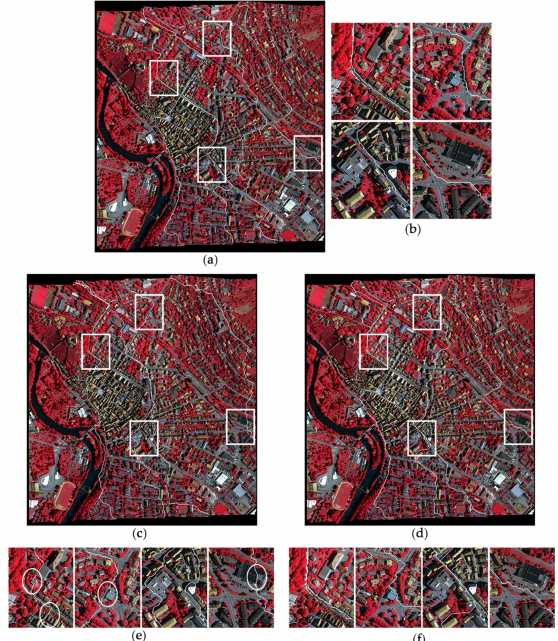
Figure 12. Results of seamline extraction and image mosaicking. ( a ) Seamline (white lines) extracted by the proposed algorithm; ( c ) seamline extracted by the Dijkstra’s algorithm with difference image; ( d ) seamline extracted by the Dijkstra’s algorithm with DSM; ( b , e , f ) are enlarged display of the white rectangle areas in ( a , c , d ), respectively. The white circles show that the seamline crossed some